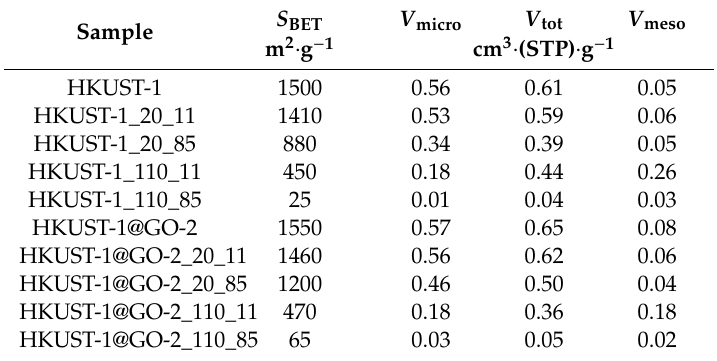
Table 3. Apparent surface area ( S BET ), micropore ( V micro ), total ( V tot ) and mesopore volume ( V meso ) before and after exposure to relative humidity